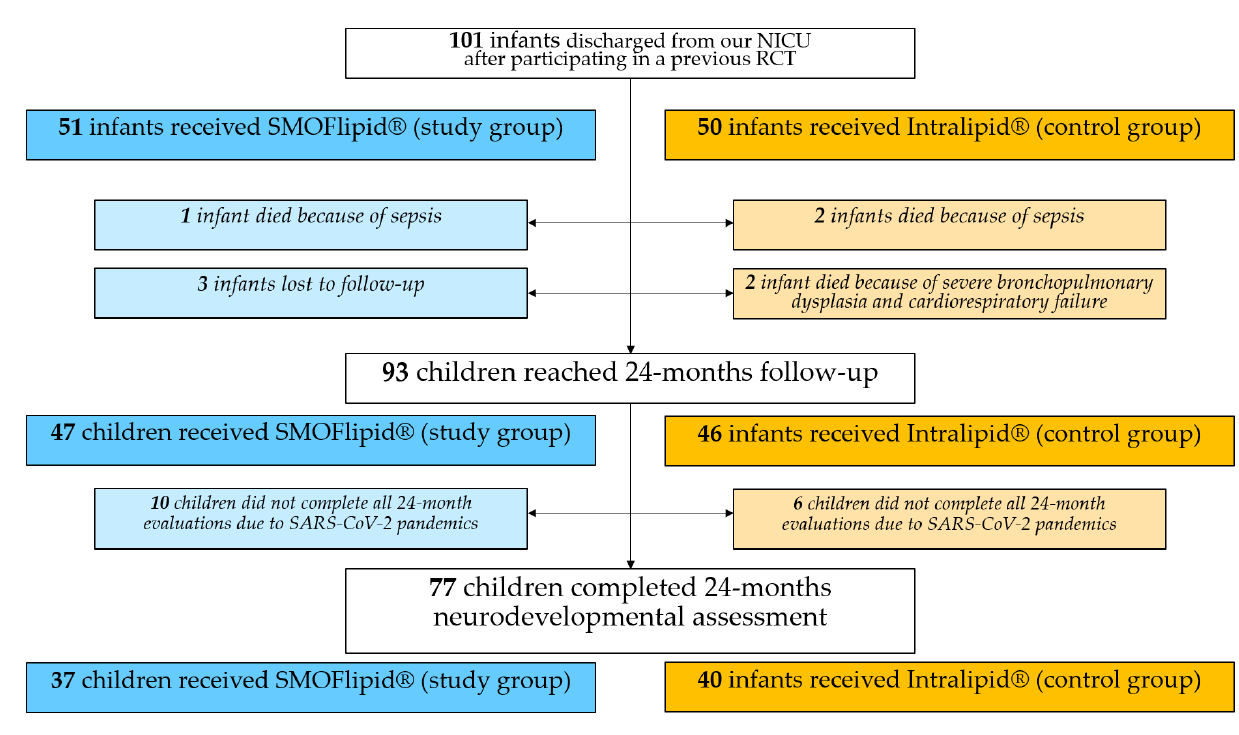
Figure 1. Population and design of the study. Table 1. Neonatal characteristics in the two